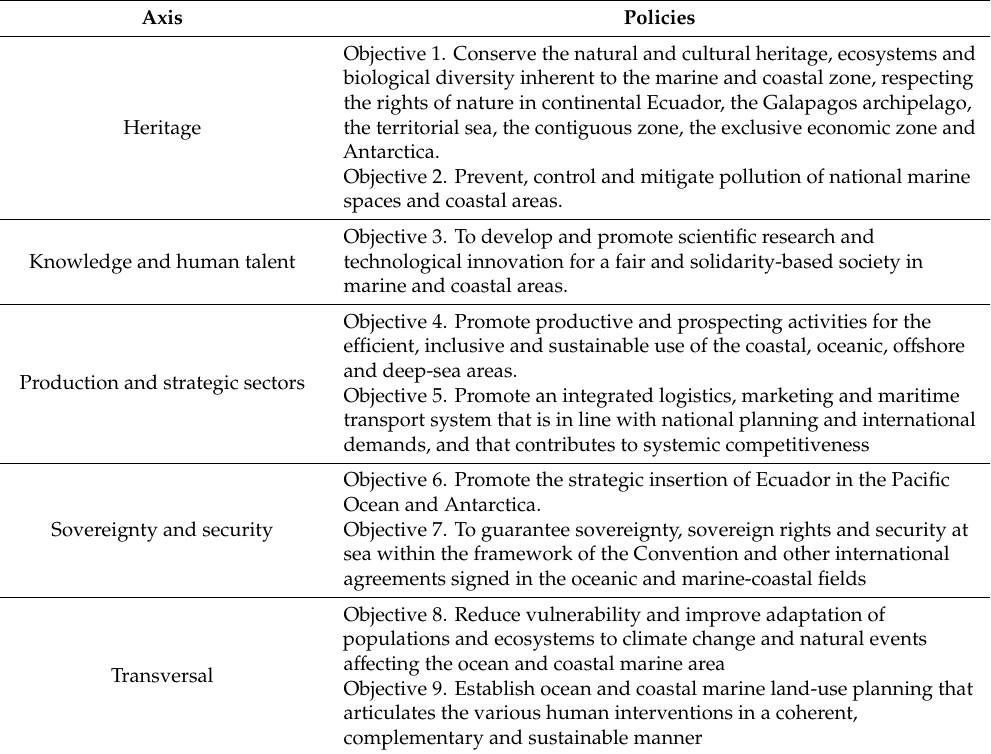
Table 5. Ecuador’s ocean and coastal